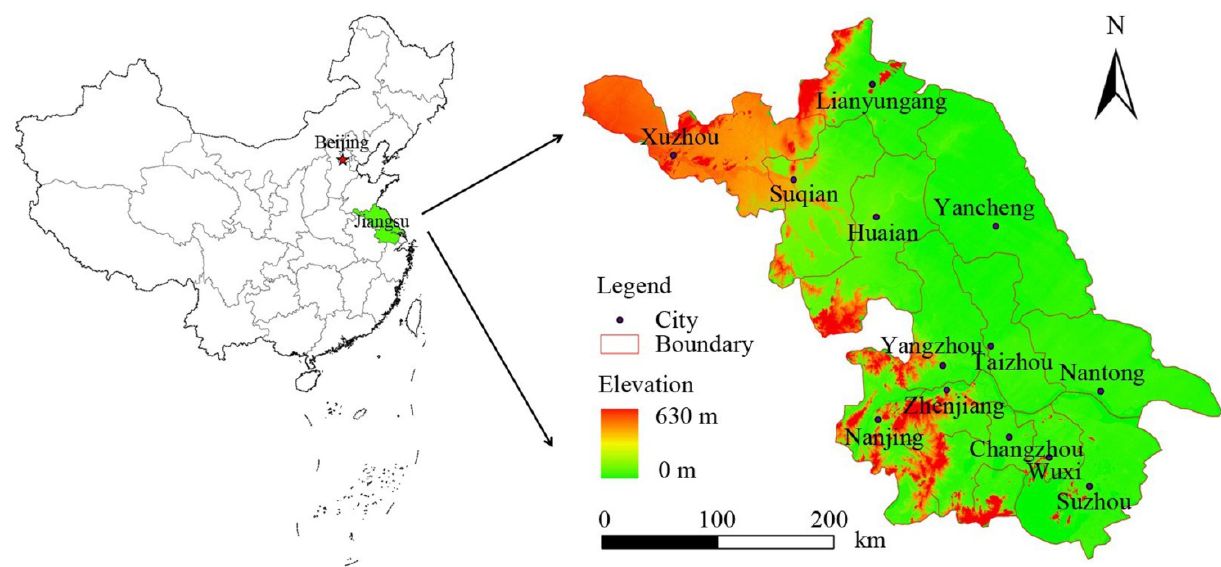
Figure 1. Location of the study